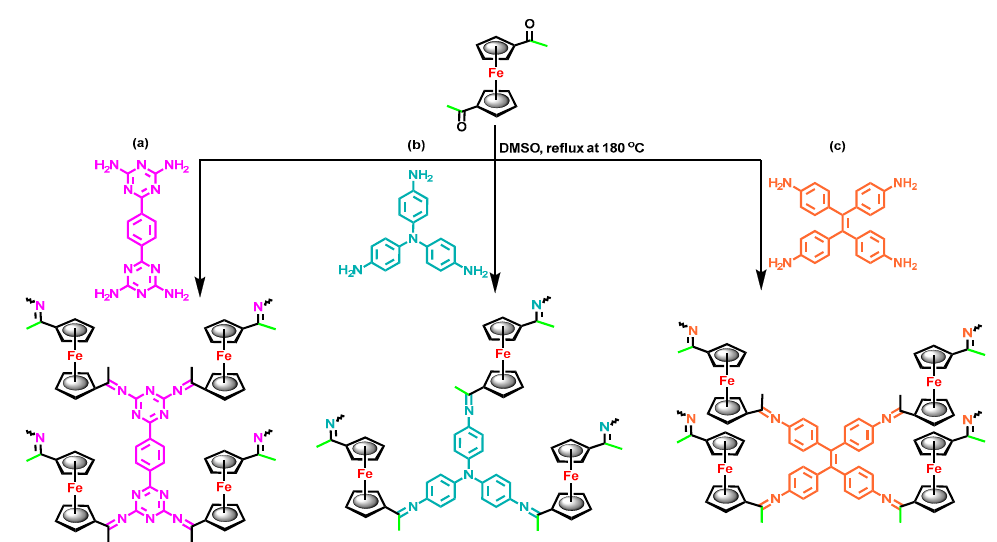
(Figure S4b): δ (ppm) 170.65, 168.46, 139.96,